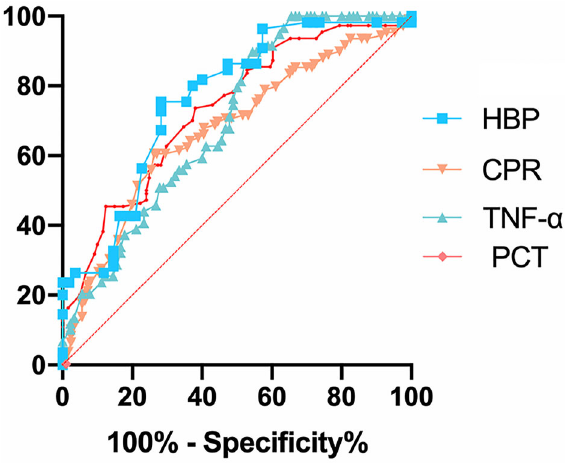
Figure 6. Receiver operating characteristic (ROC) curves for HBP, CRP, PCT, and TNF- a levels. HBP: heparin-binding protein;